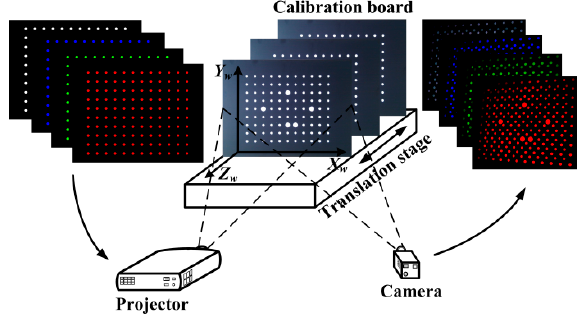
Figure 7. Set up of constructing a 3D LCA error map.